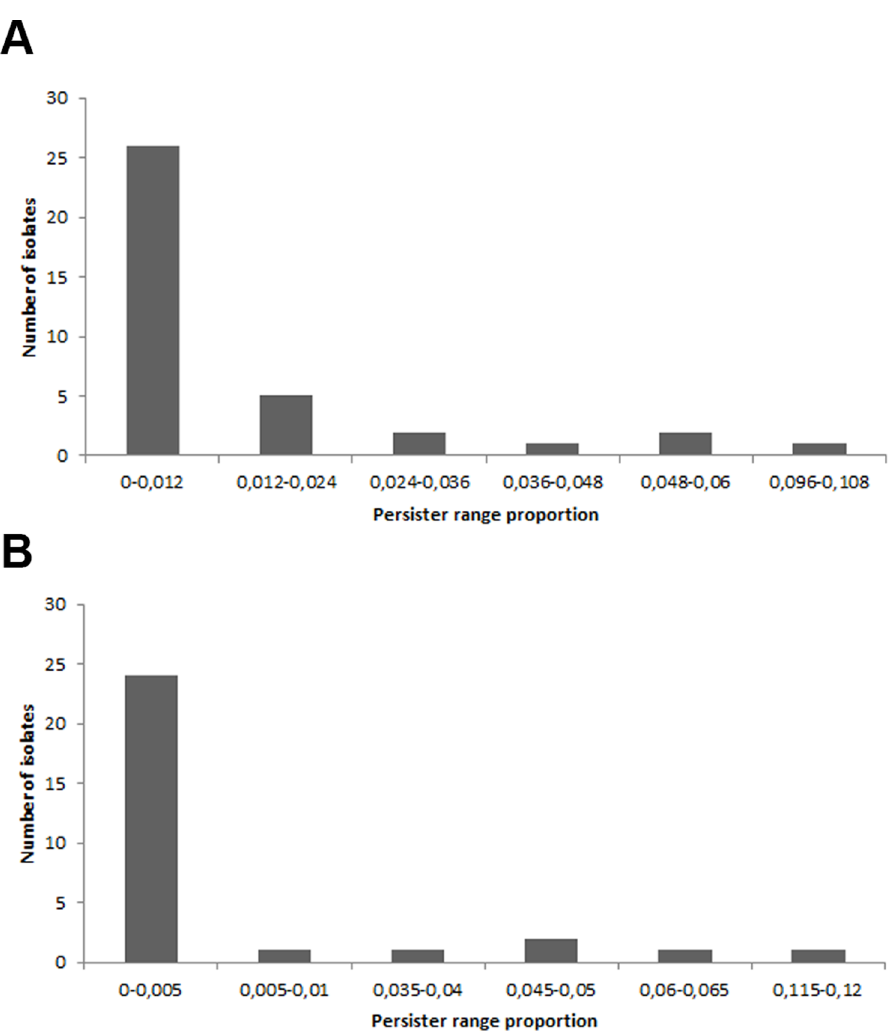
Figure 1. Frequency distribution of the persister fractions. Persister producer strains were grouped in 6 classes (defined by the square root of sample size) according to their persister fraction in the population after polymyxin B (a) or tobramycin (b) exposure. Most isolates presented persister fractions that corresponded to less than 1.2% and 0.5% of the total population for polymyxin B and tobramycin, respectively.